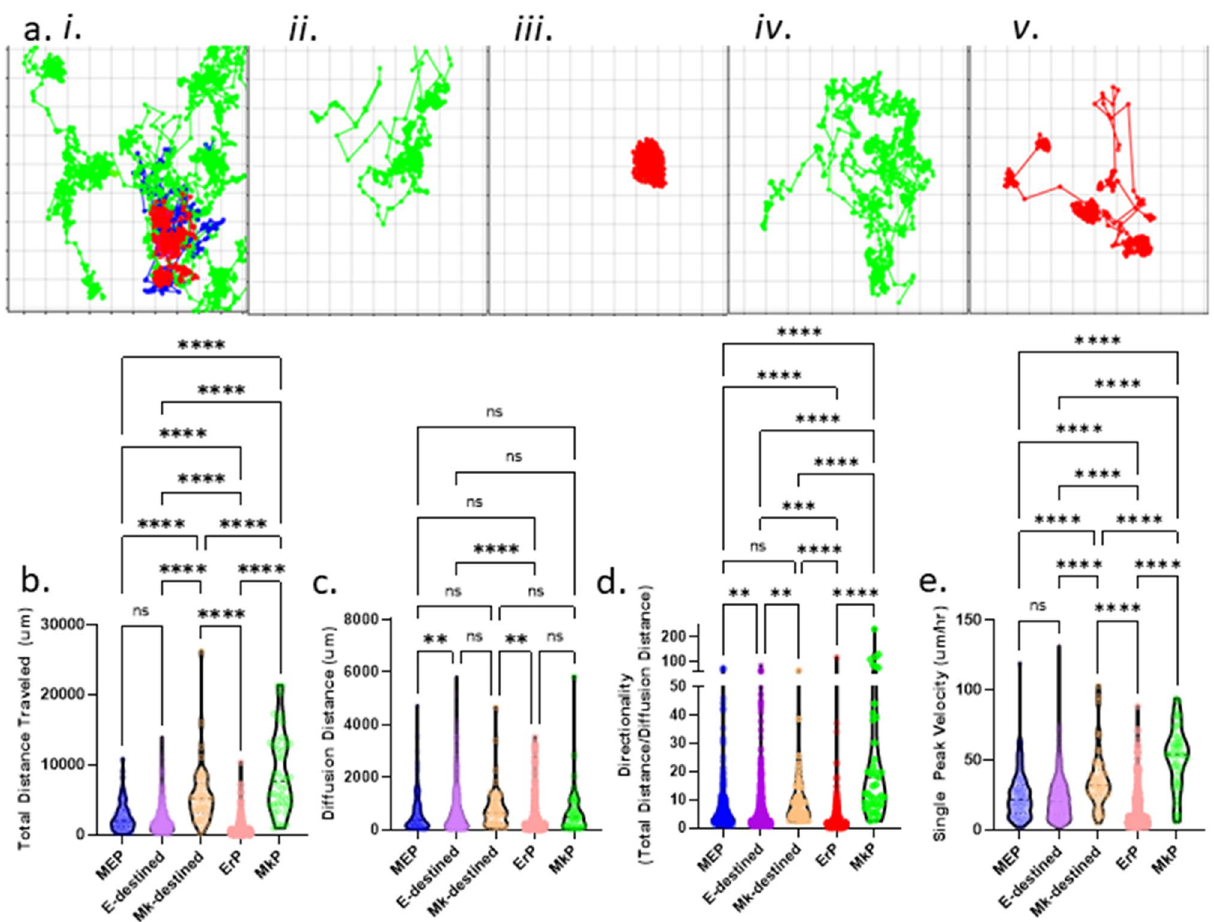
Figure 3. Motility is a differential behavioral phenotype between progenitor cells undergoing state transitions. ( a ) Corresponding representative trajectory maps for each colony output. Cell trajectories were generated based on the x,y coordinates of cells in time-lapse CFU assays. Blue trajectories represent MEPs, red trajectories represent E-destined cells, and green trajectories represent Mk-destined cells. Italic roman numerals correspond with Fig. 2a. ( b ) Total distance traveled by cell state. Total distance was measured as the sum of the distance traveled by an individual cell between time points for the entire lifetime of the bipotent MEP (blue; n = 188), E-destined (purple; n = 964), Mk-destined (orange; n = 49), committed ErP (red; n = 505), and committed MkP (green; n = 47) cell. *p < 0.05, **p < 0.01, ***p < 0.001, ****p < 0.0001, ns not significant. ( c ) Diffusion distance traveled by cell state. Diffusion distance was measured as the shortest distance between the starting and ending position of the bipotent MEP (blue; n = 188), E-destined (purple; n = 964), Mk-destined (orange; n = 49), committed ErP (red; n = 505), and committed MkP (green; n = 47) cell at the end of their lifespan. *p < 0.05, **p < 0.01, ***p < 0.001, ****p < 0.0001, ns not significant. ( d ) Directionality of motility by cell state. Directionality was calculated by the ratio of total distance over diffusion distance of bipotent MEP (blue; n = 188), E-destined (purple; n = 964), Mk-destined (orange; n = 49), committed ErP (red; n = 505), and committed MkP (green; n = 47). *p < 0.05, **p < 0.01, ***p < 0.001, ****p < 0.0001, ns not significant. ( e ) Peak velocity by cell state. Peak velocity is reported as the single highest distance traveled between two time frames over the time between frames for the bipotent MEP (blue; n = 188), E-destined (purple; n = 964), Mk-destined (orange; n = 49), committed ErP (red; n = 505), and committed MkP (green; n = 47) cell. *p < 0.05, **p < 0.01, ***p < 0.001, ****p < 0.0001, ns not